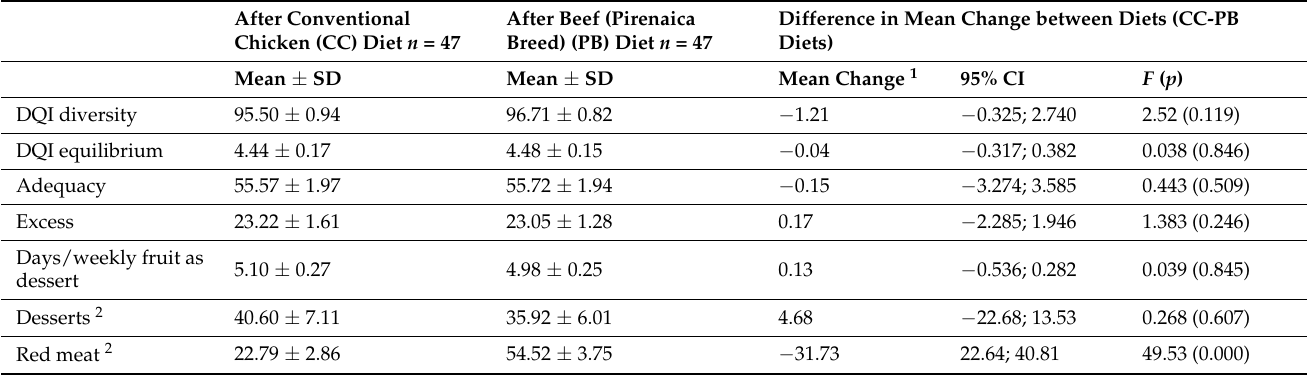
Table 3. Differences in some food groups, DQI diversity and equilibrium components and fruit consumption as dessert, after Conventional Chicken versus beef (Pirenaica breed) diets in both periods analyzed through a crossover design